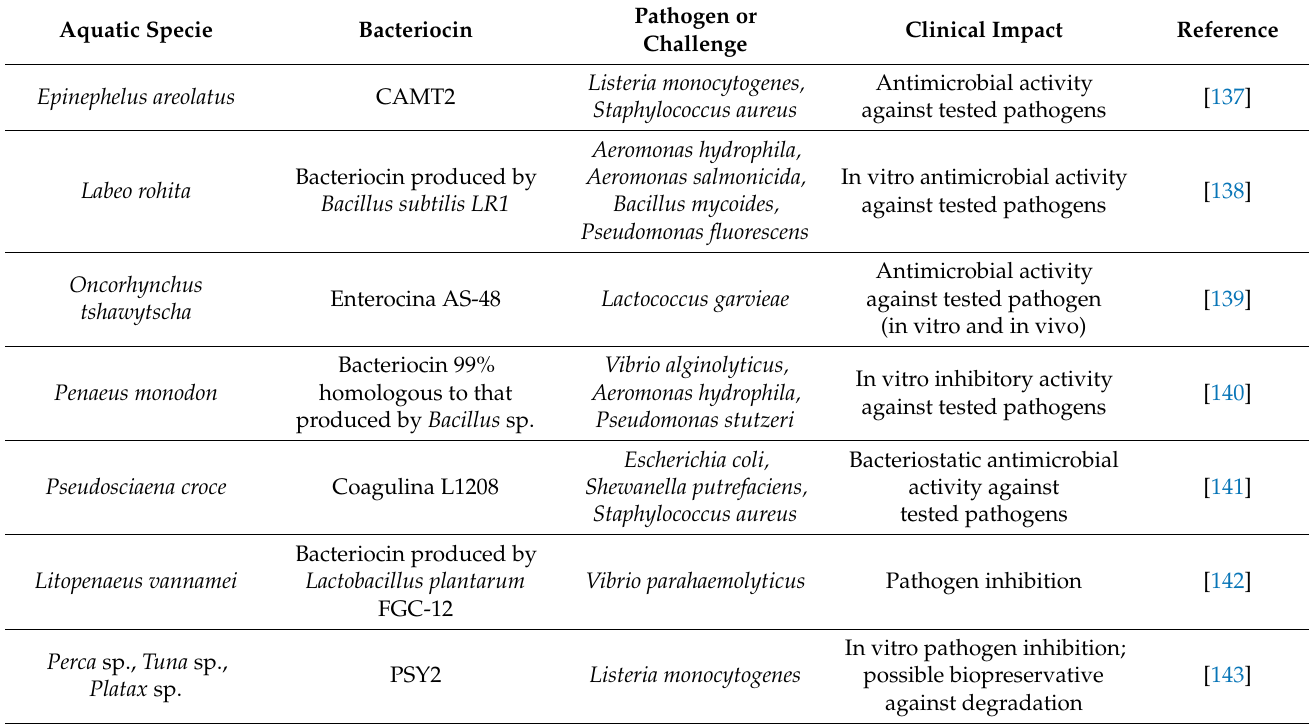
Table 2. Overview of bacteriocin effects in fish health or against aquaculture pathogenic